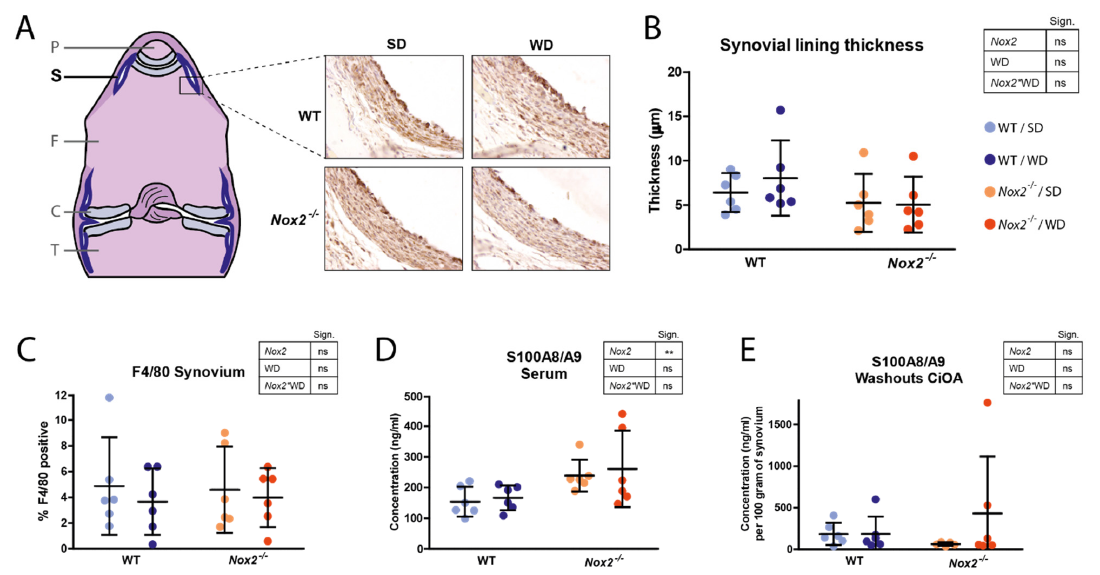
Figure 4. Nox2 knockout does not affect synovial lining thickness and S100A8/A9 expression at day seven of CiOA. ( A ) Illustration shows a schematic overview of a frontal section of an H&E-stained knee joint. P, patella; S, synovium; F, femur; C, cartilage; T, tibia. Pictures show sections immunohistochemically stained for F4/80 and are representative of the mean of each group (400 × magnification). ( B ) Synovial lining thickness at day seven of CiOA was scored on F4/80-stained histological sections by measuring the thickness in µ m. Three sections of different standardized depths were scored per knee joint. ( C ) F4/80 positive staining was measured and quantified as the percentage of positive staining in the outer 200 µm of synovium. ( D , E ) Concentrations of S100A8/A9 in serum ( D ) and synovial washouts ( E ) using ELISA. Data are presented as mean and 95% CI’s. n = 10. p -value summary resulting from two-way ANOVA shown in tables: **, p < 0.01; ns, p > 0.05. No mice were excluded from analysis.